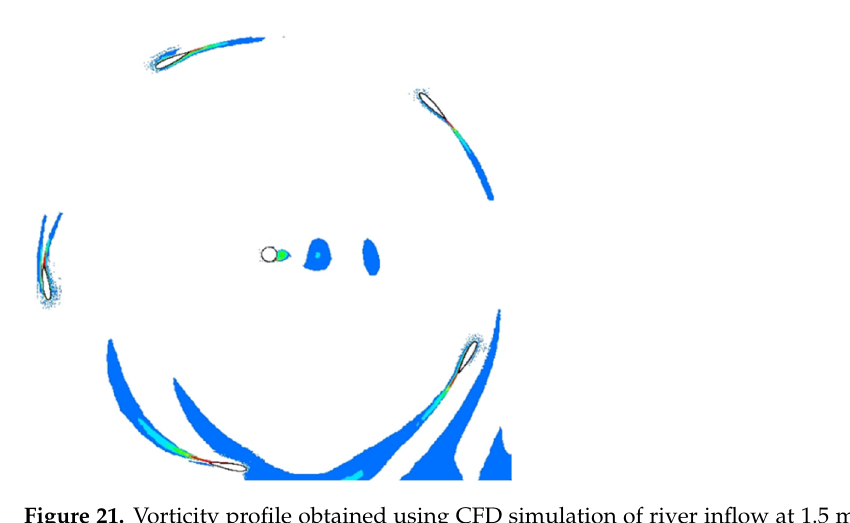
Figure 19. Velocity profile obtained using CFD simulation of river inflow at 1.5 m/s and turbine rotation rate of 44 RPM.